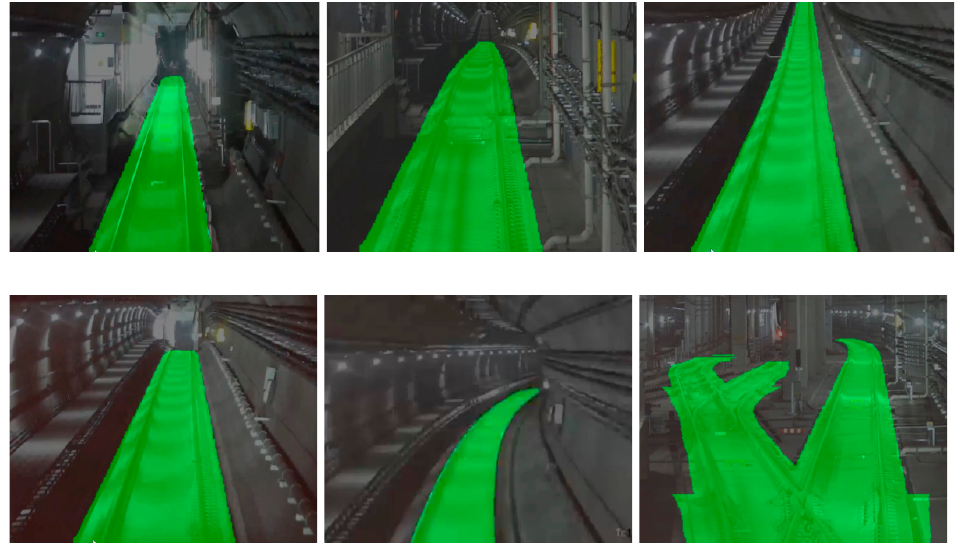
Figure 19. Track region extraction in different subway tunnel conditions (including uphill and downhill straight track line, curved track line, multiple turnouts). Table 4. The results of the comparative experiment under subway tunnel conditions